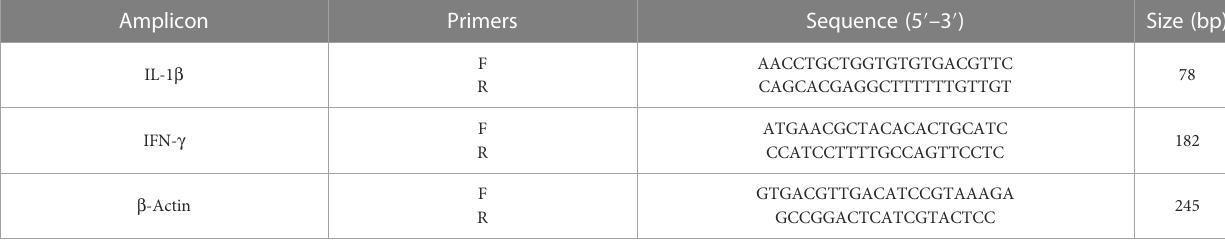
TABLE 1 The primers applied for real-time